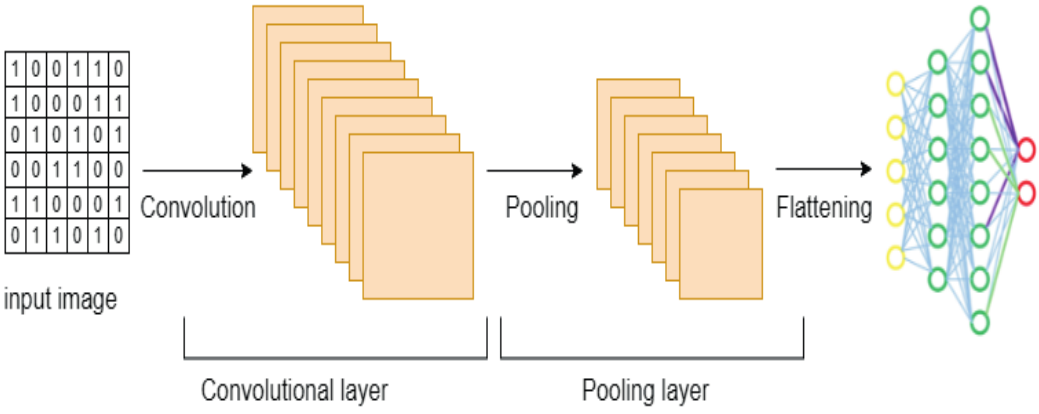
Fig. 4. General convolutional neural network